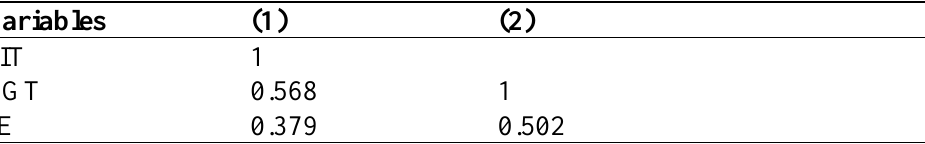
Figure 1. Variable Correlation Table 3: Correlation of the